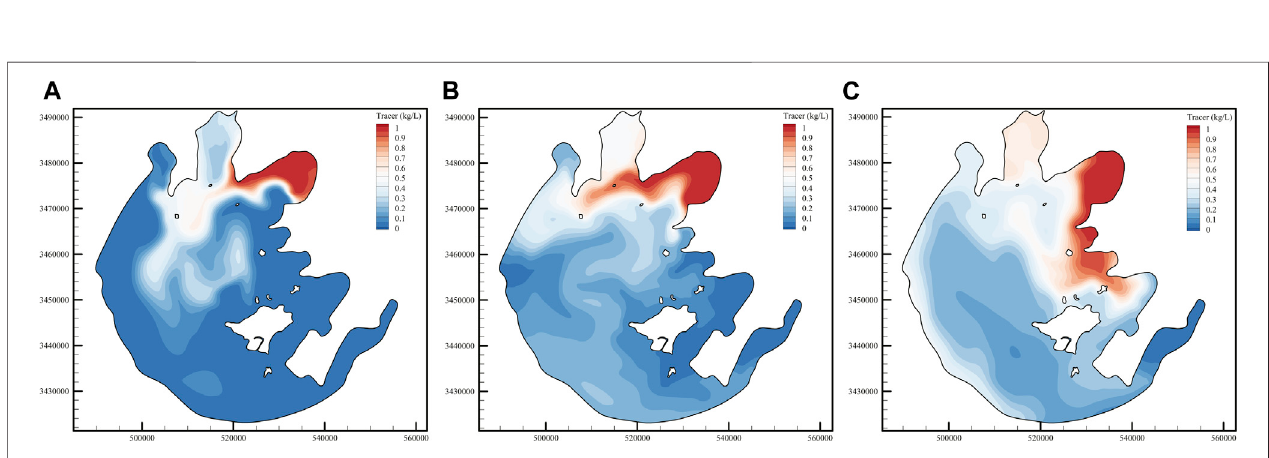
FIGURE 14 | Time series of tracer concentration images with the consideration of vegetation: (A) Jul, 31st, (B) Sept, 30th, and (C) Nov, 30th.